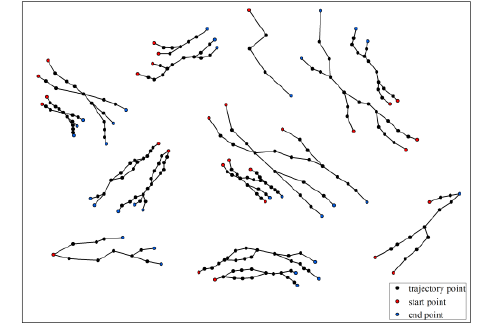
Figure 3. Simulated complex trajectories.